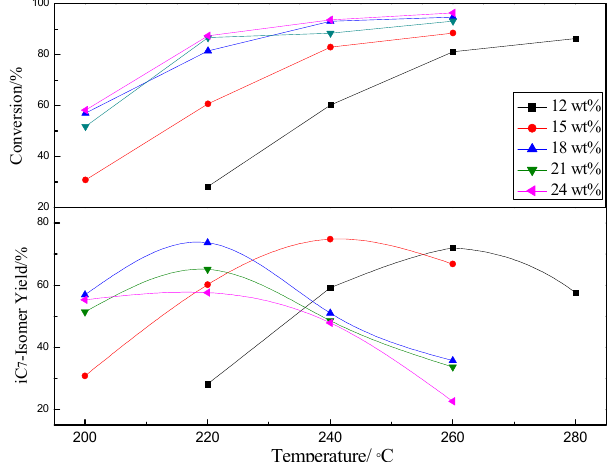
Figure 6. The activity of the Cr-Pt/WZ catalysts with different WO 3 contents. Reaction condition: n(H 2 ):n(C 7 ) = 9 mol/mol, LHSV = 0.7 h − 1 , and P = 1.0 MPa, T = 200–280 °C. n(H − 1 , and P = 1.0 MPa, T = 200–280 ◦ 2 ):n(C 7 ) = 9 mol/mol, LHSV = 0.7 h